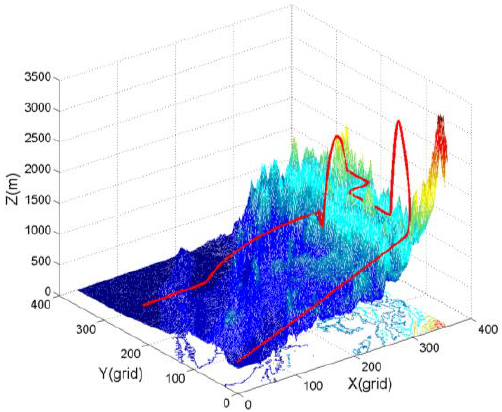
Figure 6. The 3D terrain and simulation trajectory.